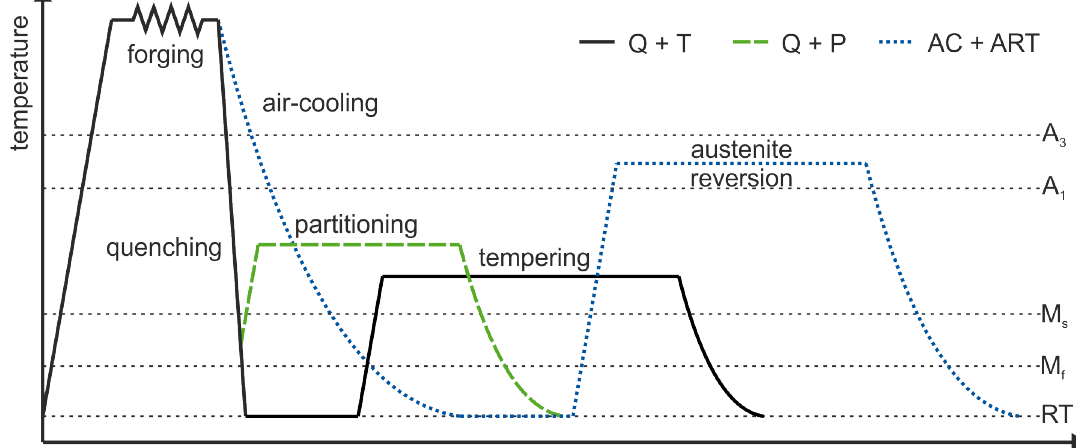
Figure 1. Comparison of the new air-cooling + austenite reversion tempering process (AC + ART) compared to the standard quenching + tempering (Q + T) and quenching + partitioning (Q + P) heat treatments. The time axis of this diagram is schematic and does not reflect the real tempering